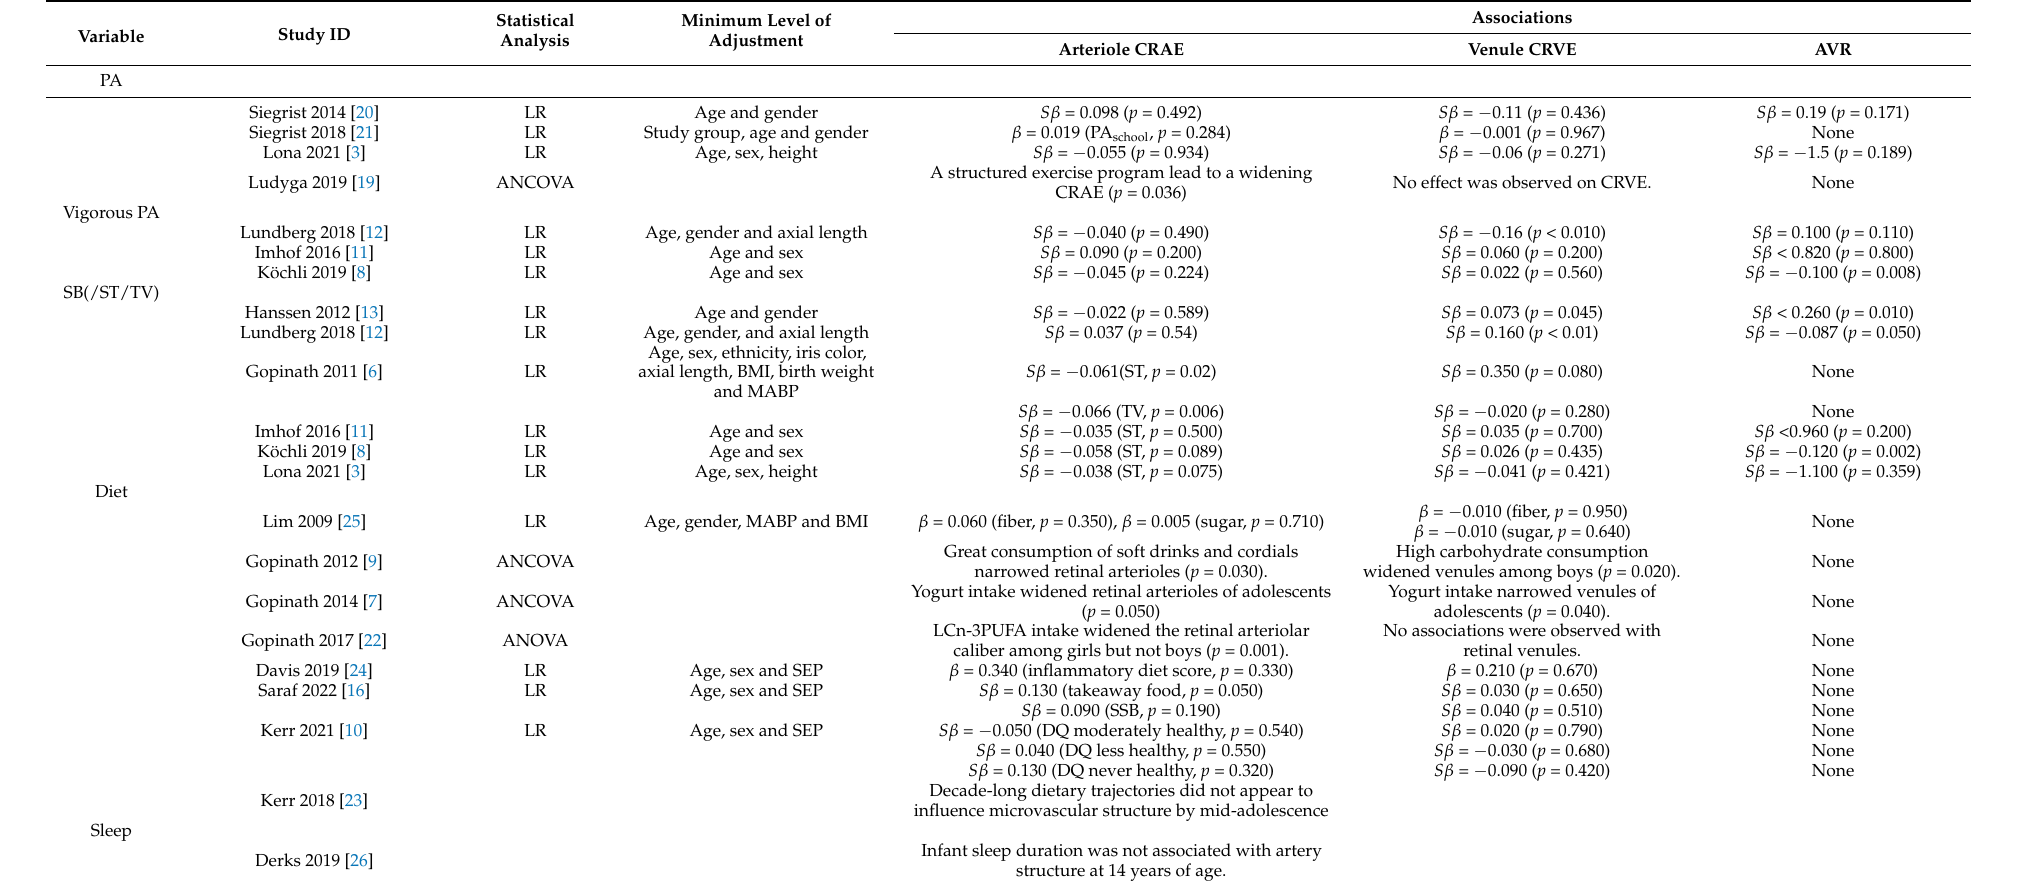
Table 2. Studies reported associations between PA/SB/Sleep and